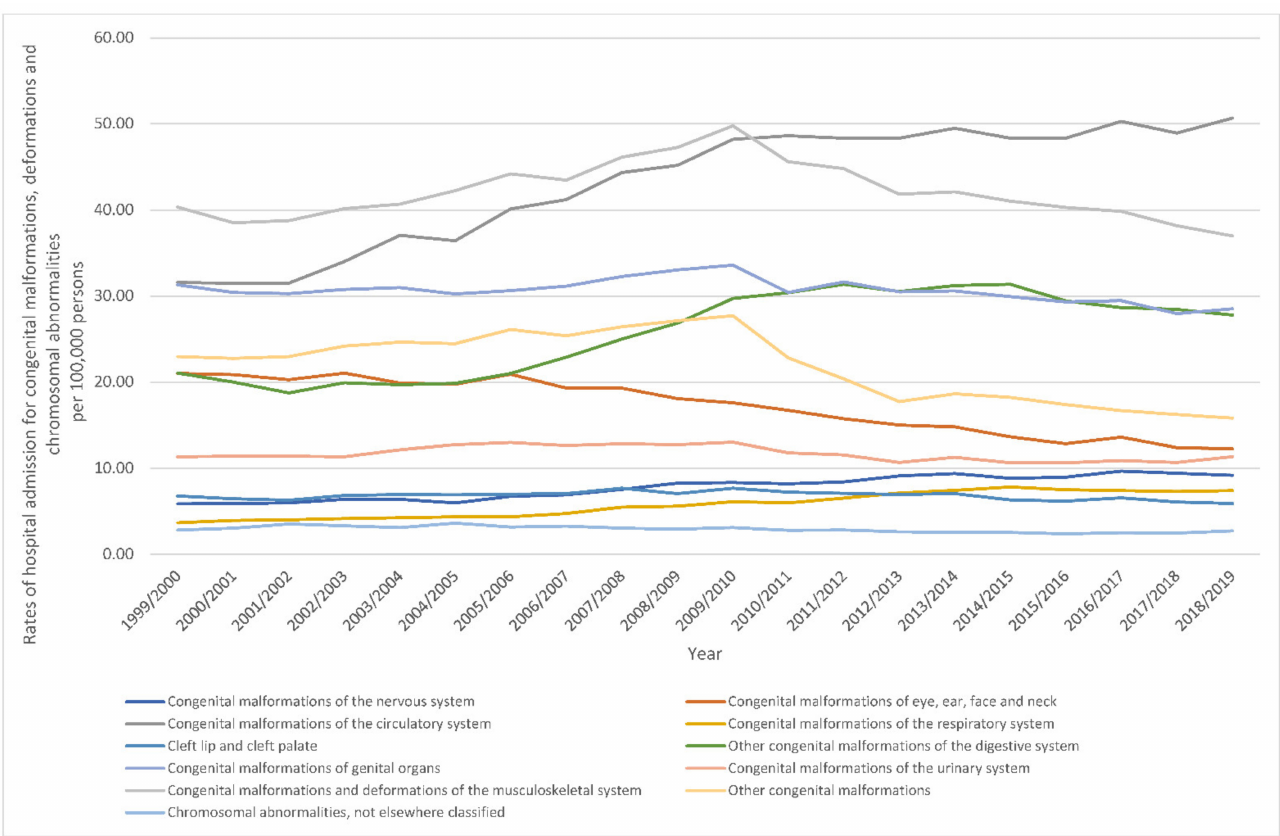
Figure 1. Rates of hospital admission for congenital malformations, deformations and chromosomal abnormalities in England and Wales stratified by type between 1999 and 2019.